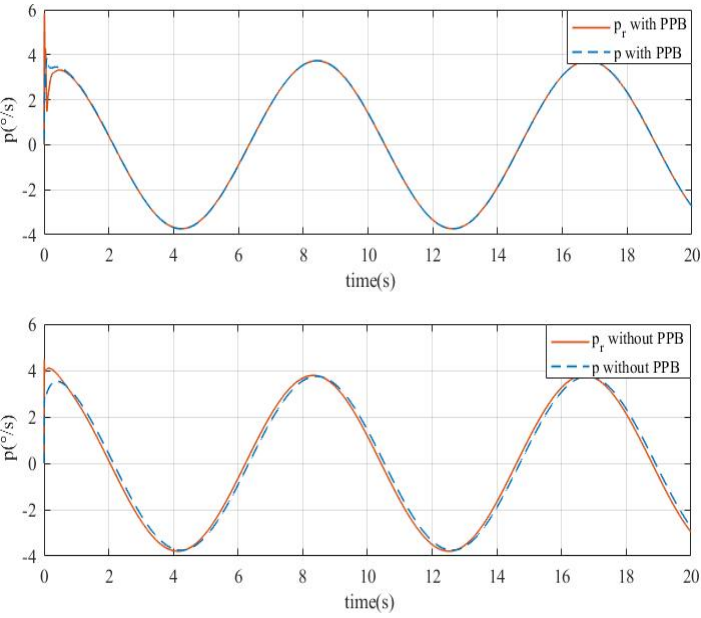
Figure 7. Tracking response of p .